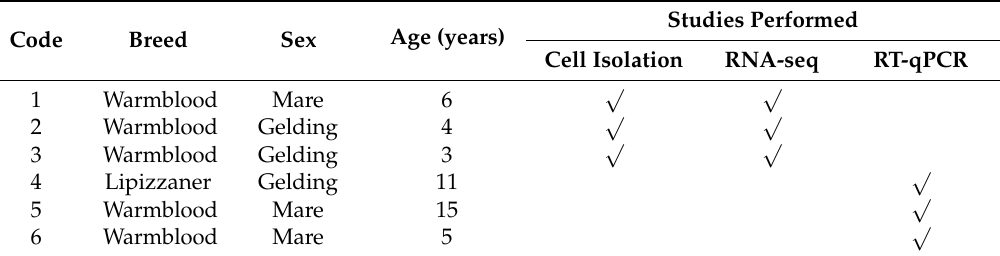
Table 1. Details of horses used in